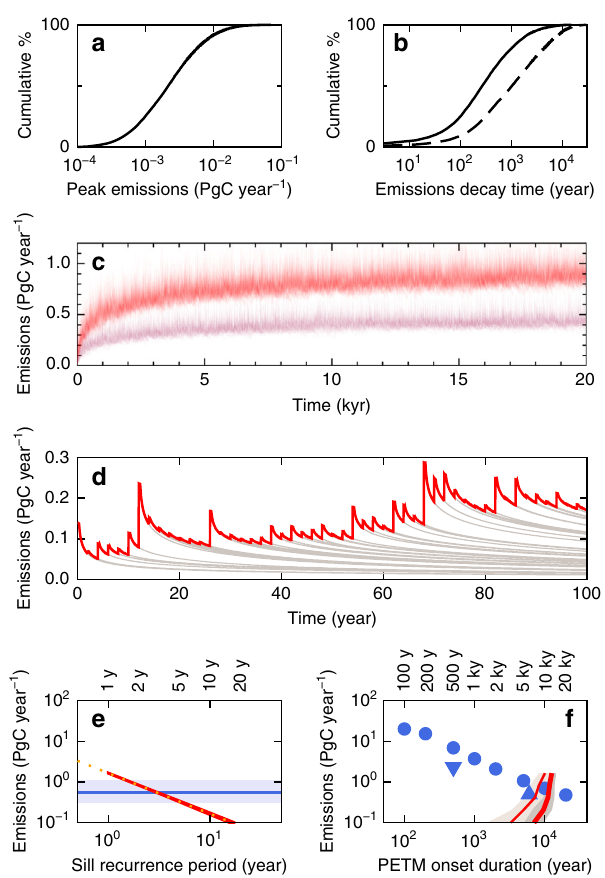
Fig. 5 Sill province carbon emissions at constant time period between successive sill intrusions. a Cumulative histogram of peak carbon emissions (averaged over the fi rst year after injection) for individual NAIP sills, calculated from new NAIP sill dimension database (Fig. 4) using new emissions parameterisation (Methods). b Cumulative histogram of emissions decay time for individual NAIP sills calculated in the same way: dashed line for maximum sill thicknesses; solid line for mean sill thicknesses. c Stack of 30 simulated carbon emissions histories for constant sill intrusion intervals of τ repeat = 2 years (red) and 4 years (maroon). d Expanded view of fi rst 100 years of one simulation with τ repeat = 2 years, showing combined emissions from the sill province as a red line and contributions from individual sills as grey lines. e Relationship between long-time (post-10kyr) mean emissions fl ux and sill recurrence period from multiple experiments like c . Horizontal blue line and envelope show most likely value 5,6 and range 4,5 of peak emissions required to explain PETM onset determined from climate models. Yellow dots show power law approximation in Eq. 1. f Comparison between peak carbon fl uxes from our sill province models (lines) and peak fl uxes estimated from PETM climate models (spots) as functions of PETM onset duration. Sill province models: thinner black line shows when the long-time mean is fi rst reached; thicker black line shows when the 1kyr running mean fi rst reaches long-time mean; shaded regions show±1 s.d. for the 100-run ensembles. Climate models: circles are from joint inverse modelling of pH and carbon isotope composition 7 ; triangles are from forward modelling of carbon isotope composition and deep- sea carbonate dissolution (triange 6 ; inverted triangle 57